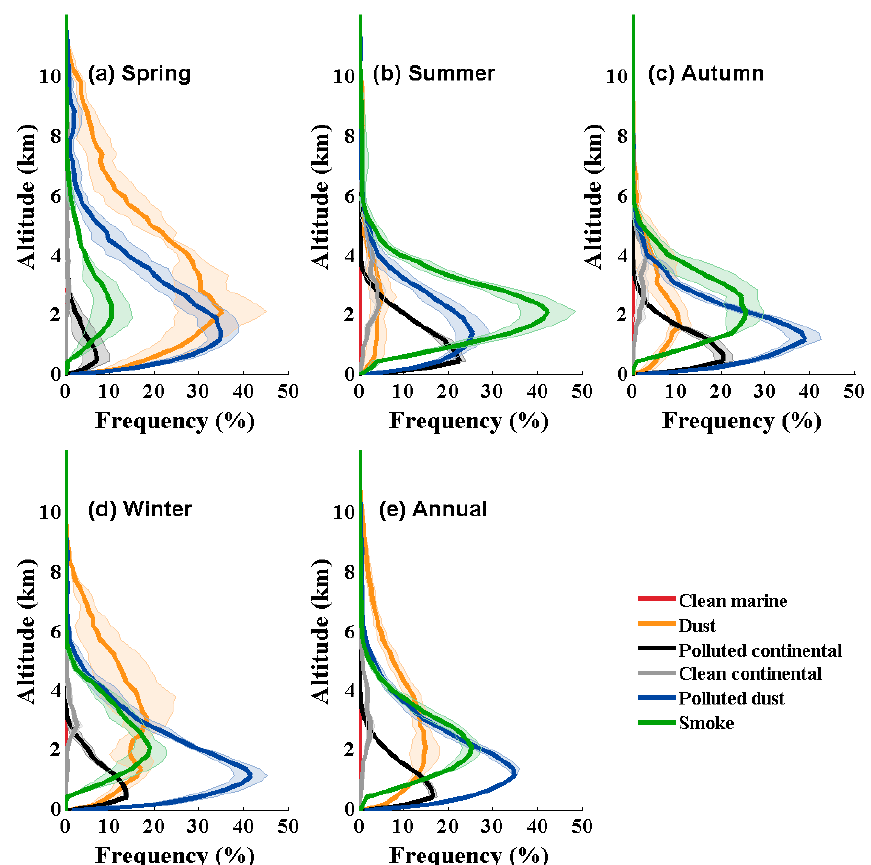
Figure 10. Full-resolution seasonal and annual average occurrence frequencies of aerosols versus altitude over central China from March 2007 to February 2016. The lightly shaded solid line indicates the inter-annual standard deviation of the vertical distributions of aerosol.